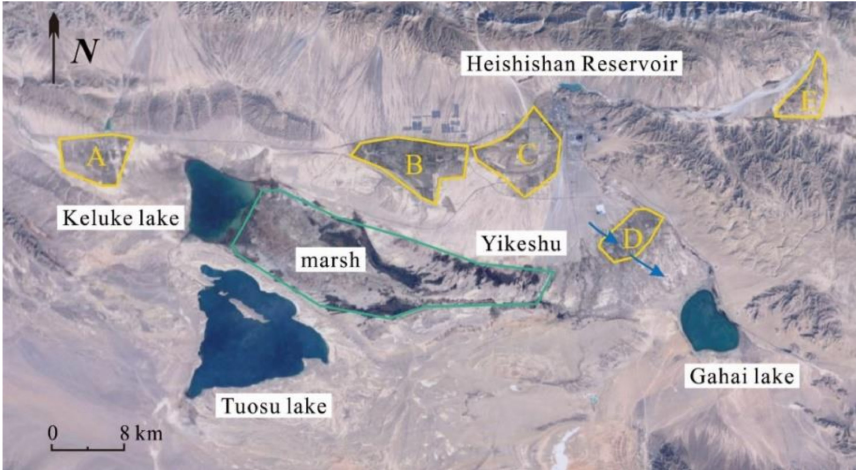
Figure 8. The distribution of irrigation area in Delingha. A, B, C, D, F represents Huaitoutala, Gebi, Delingha, Gahai, and Zelinggou irrigation area, respectively. The blue arrow represents the direction of weak groundwater runoff after the Bayan River